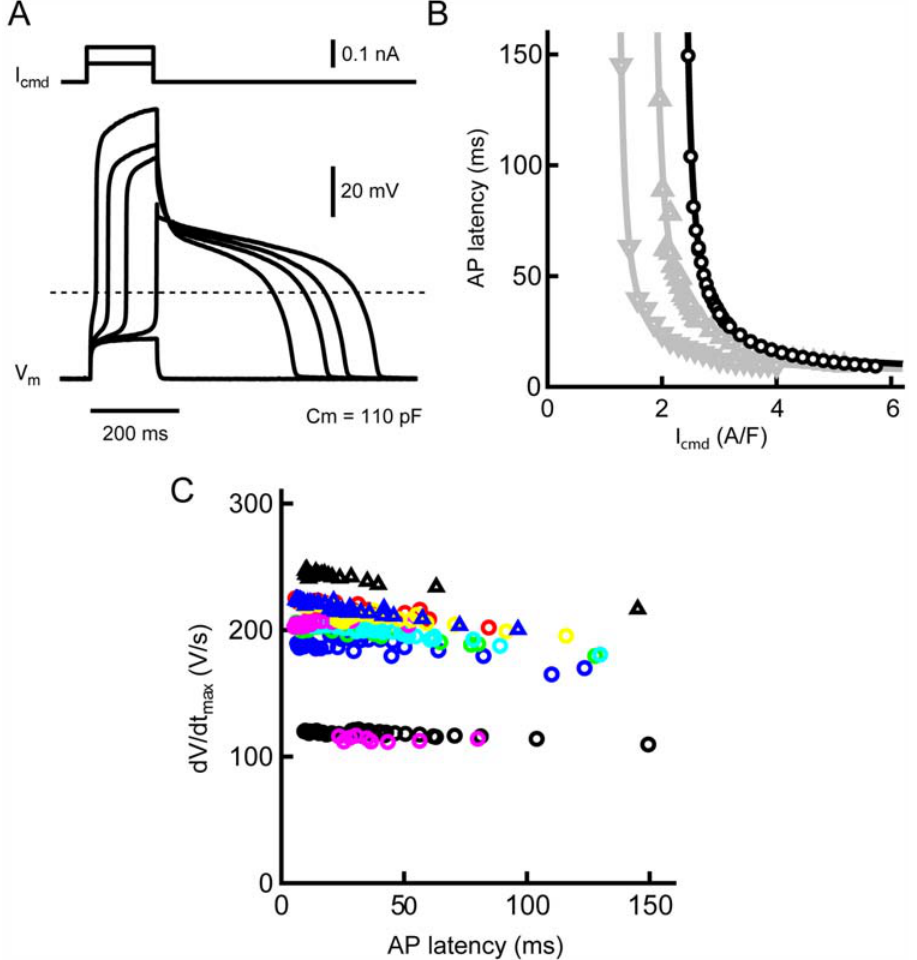
Figure 7. Effects of reduced depolarizing currents on action potential onset in isolated single myocytes. A. Typical traces of action potentials (lower records) evoked by a small command current (upper traces). B. Relationship between action potential latency and command current amplitude. Different symbols correspond to different myocytes. C. Relationship between the rate of rise of action potential (dV/dt max ) and action potential latency. Different symbol correspond to different myocytes.